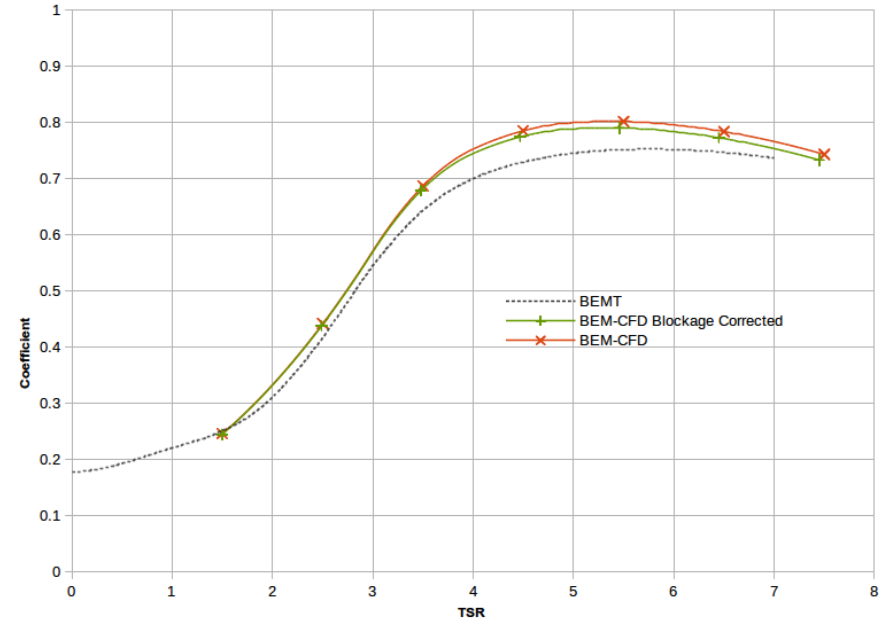
Figure 7. Comparison of IFREMER rotor results for C Fa (coefficient of axial thrust) between BEM-CFD and BEMT for a range of TSRs. Blockage-corrected BEM-CFD results are included for